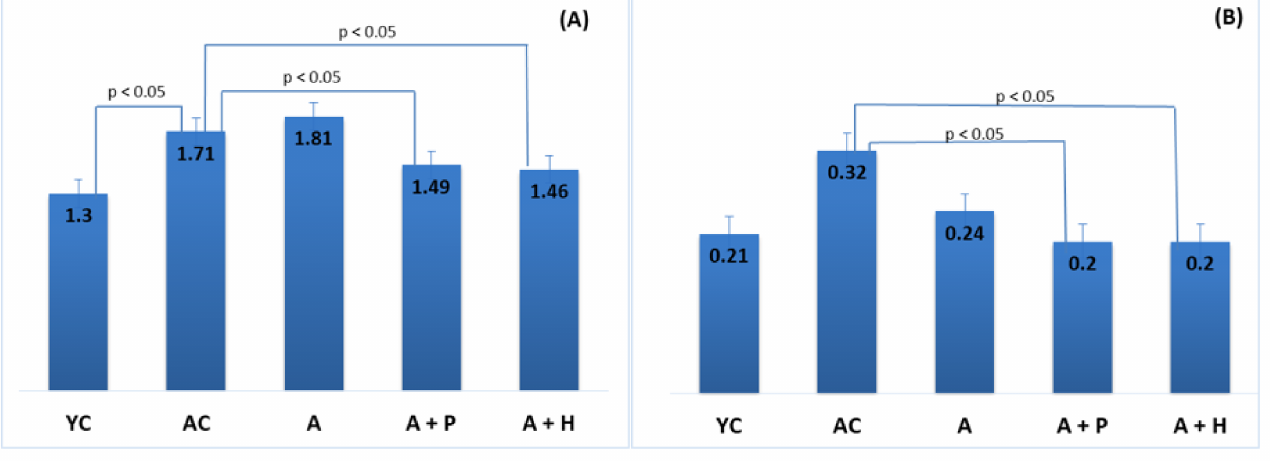
Figure 4. Atherogenic indices: ( A ) TC/HDL ratio and ( B ) LDL/HDL